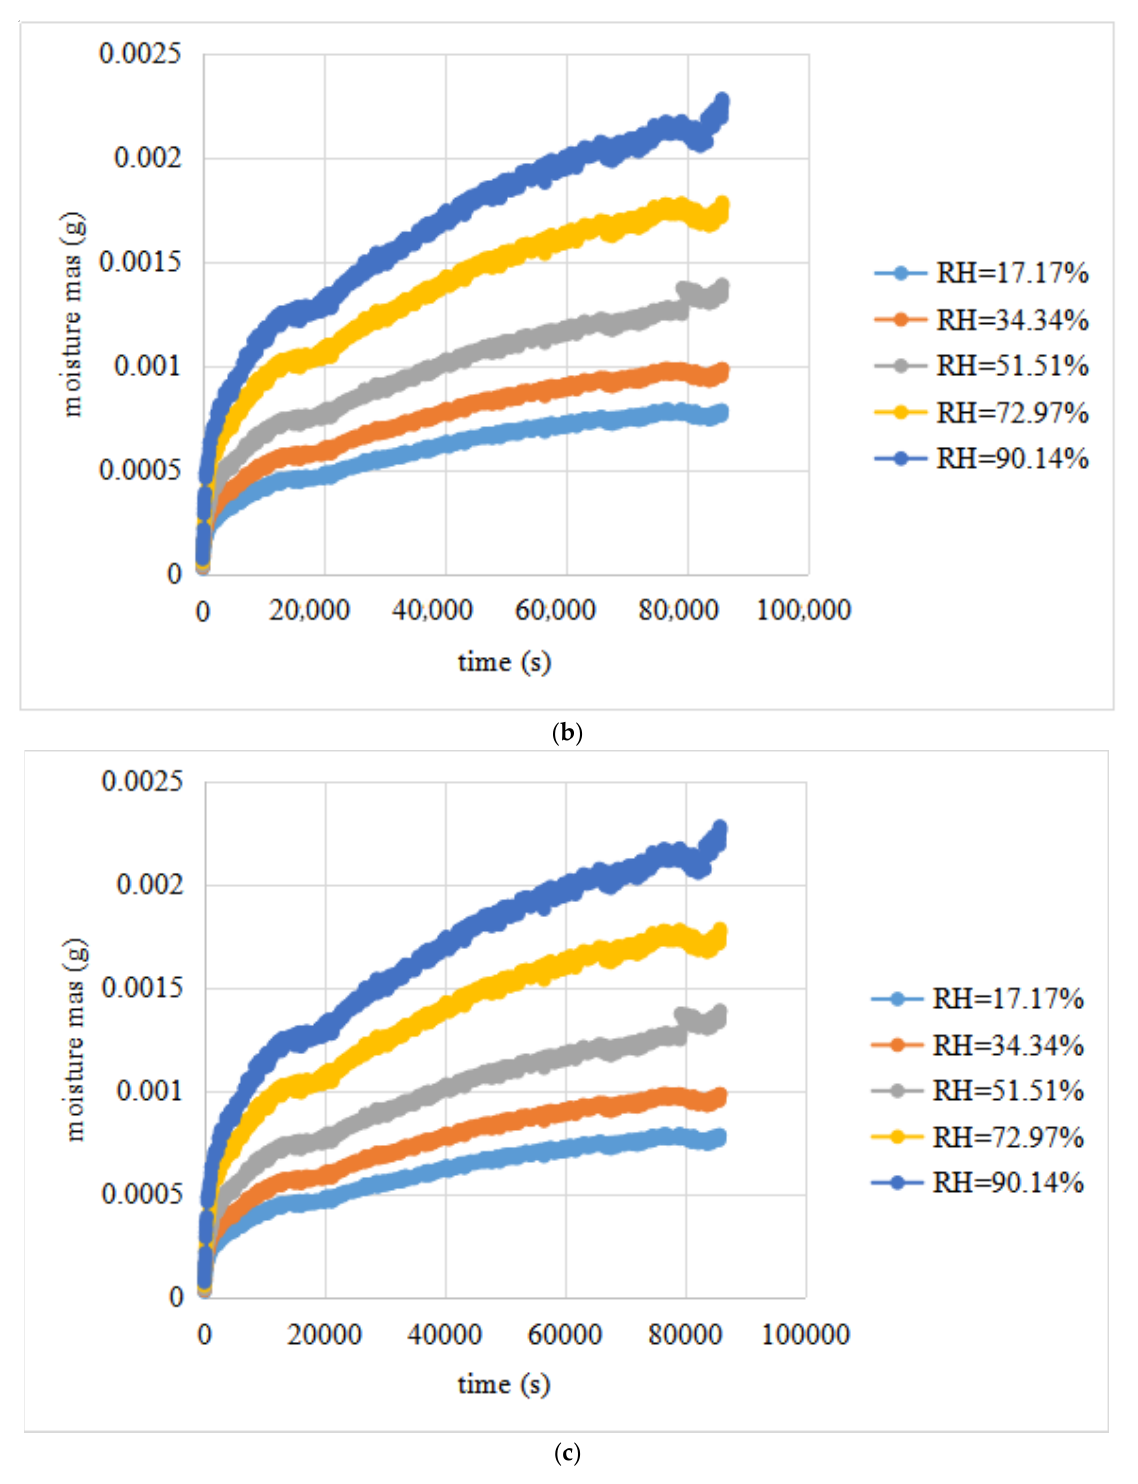
Figure 8. Experimental data for the water–gas diffusion in the limestone: ( a ) original data for the water vapour diffusion of the L-1 test piece; ( b ) original data for the water vapour diffusion of the L-2 test piece; ( c ) original data for the water vapour diffusion of the L-3 test piece.